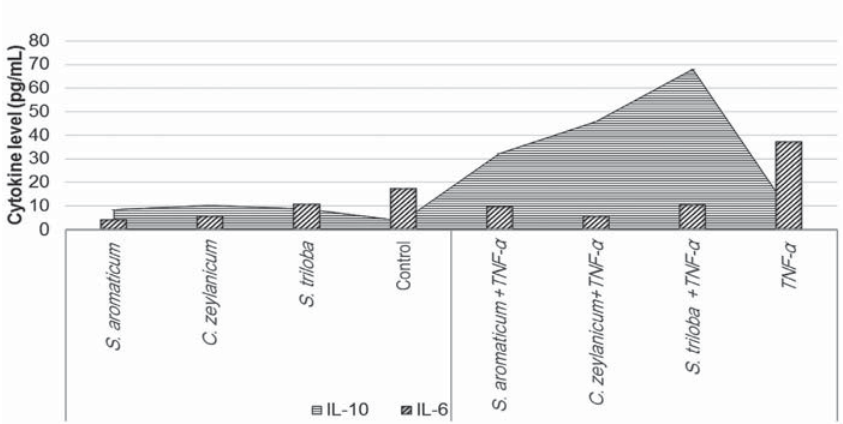
Figure 6- IL-6 and IL-10 levels determined in the culture supernatant of dental pulp stem cells (DPSCs). IL-10 level reached 67.9 pg/mL with S. triloba in response to TNF- (cid:68)